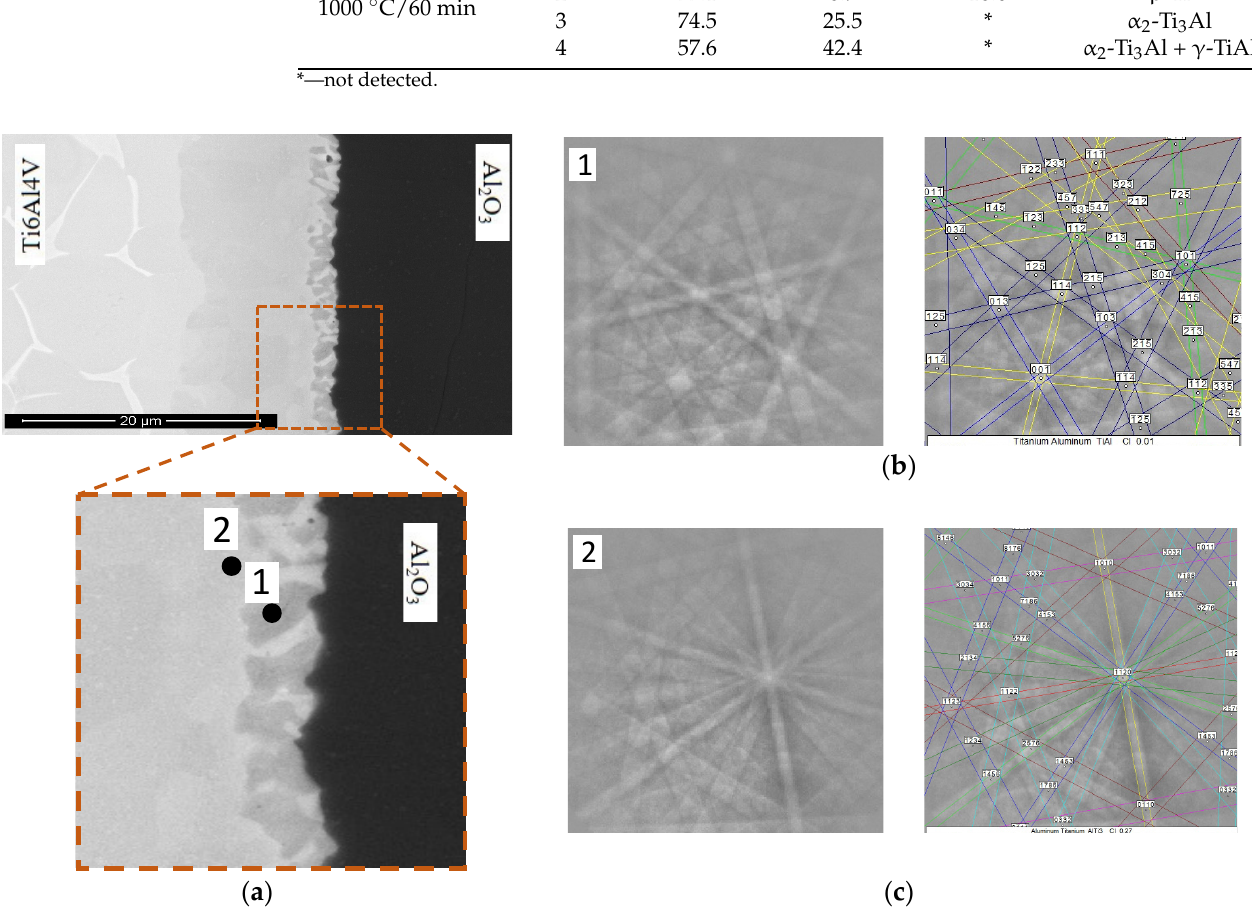
Figure 7. ( a ) SEM images of the interface produced with Ti thin film processed at 1000 °C for 60 min, ( b ) EBSD Kikuchi patterns of the grain marked as 1 in ( a ) indexed as γ -TiAl, and ( c ) EBSD Kikuchi patterns of the grain marked as 2 in ( a ) indexed as α 2 -Ti 3 Al.